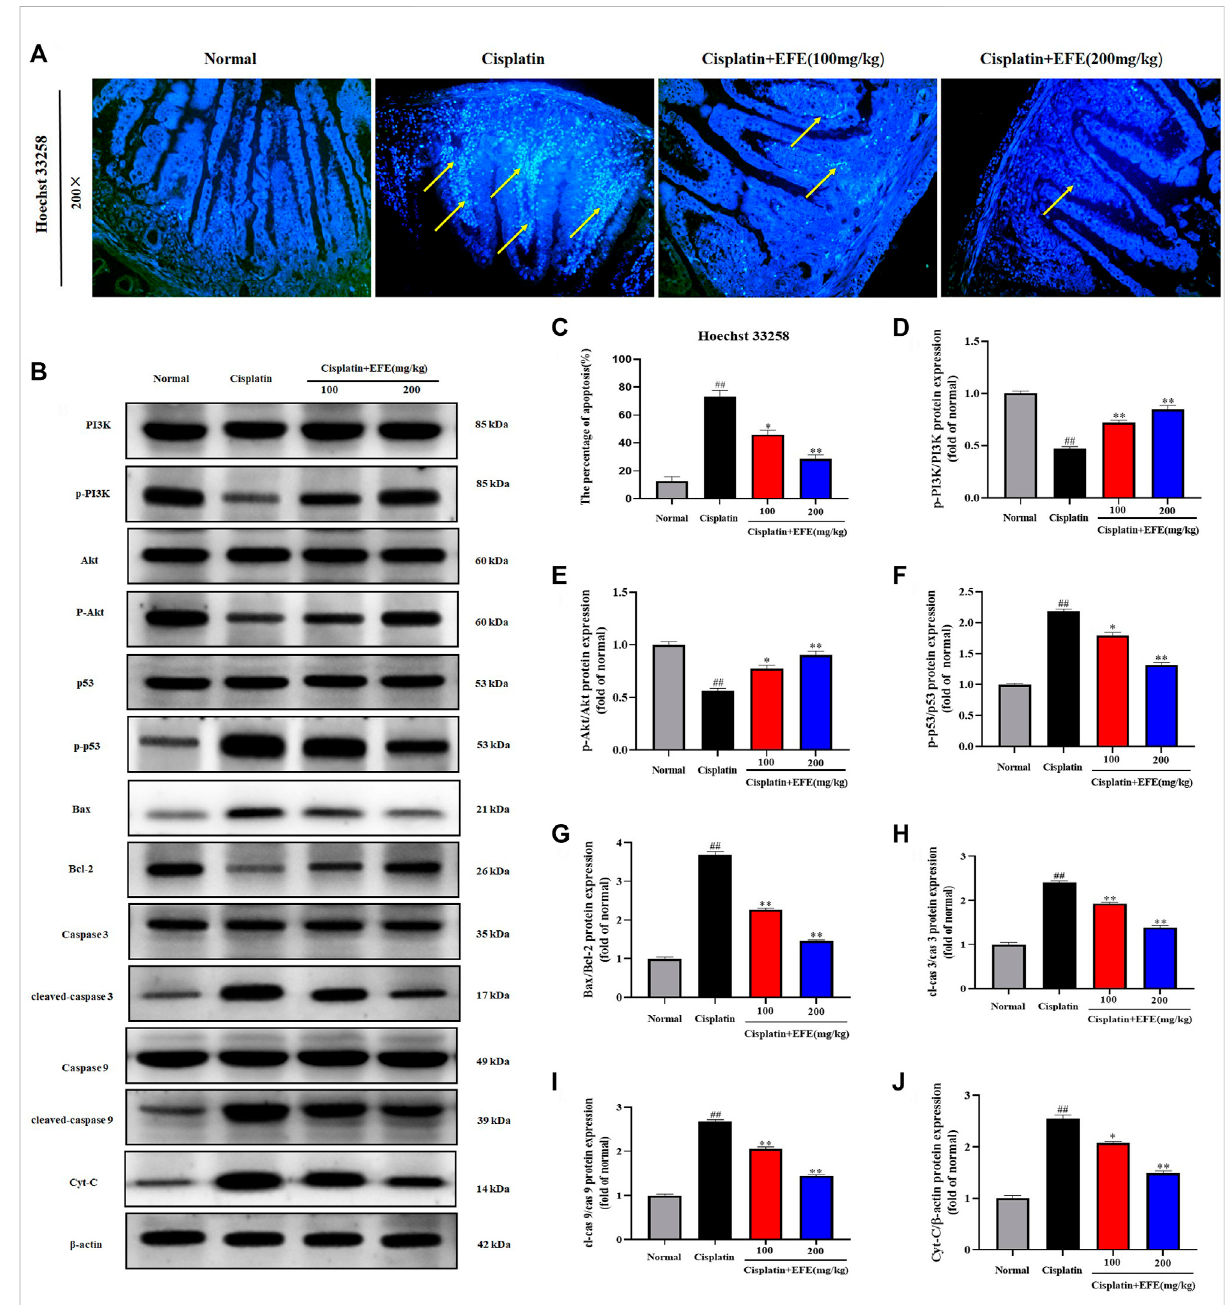
FIGURE 6 EffectofEFEoncisplatin-inducedintestinalapoptosisinmice (A) ,andthepercentageofapoptosis (C) ;EffectofEFEonp-PI3K,PI3K,p-Akt,Akt, p-p53,p53,Bax,Bcl-2,cleavedcaspase-9,caspase-9,cleavedcaspase-3,caspase-3,andcytochromecexpressionlevelsinmouseintestinaltissues (B,D – J) . Note: Values are expressed as Mean ± S.D., ( n = 10). ## p < 0.01 vs. normal group; * p < 0.05, ** p < 0.01 vs. model